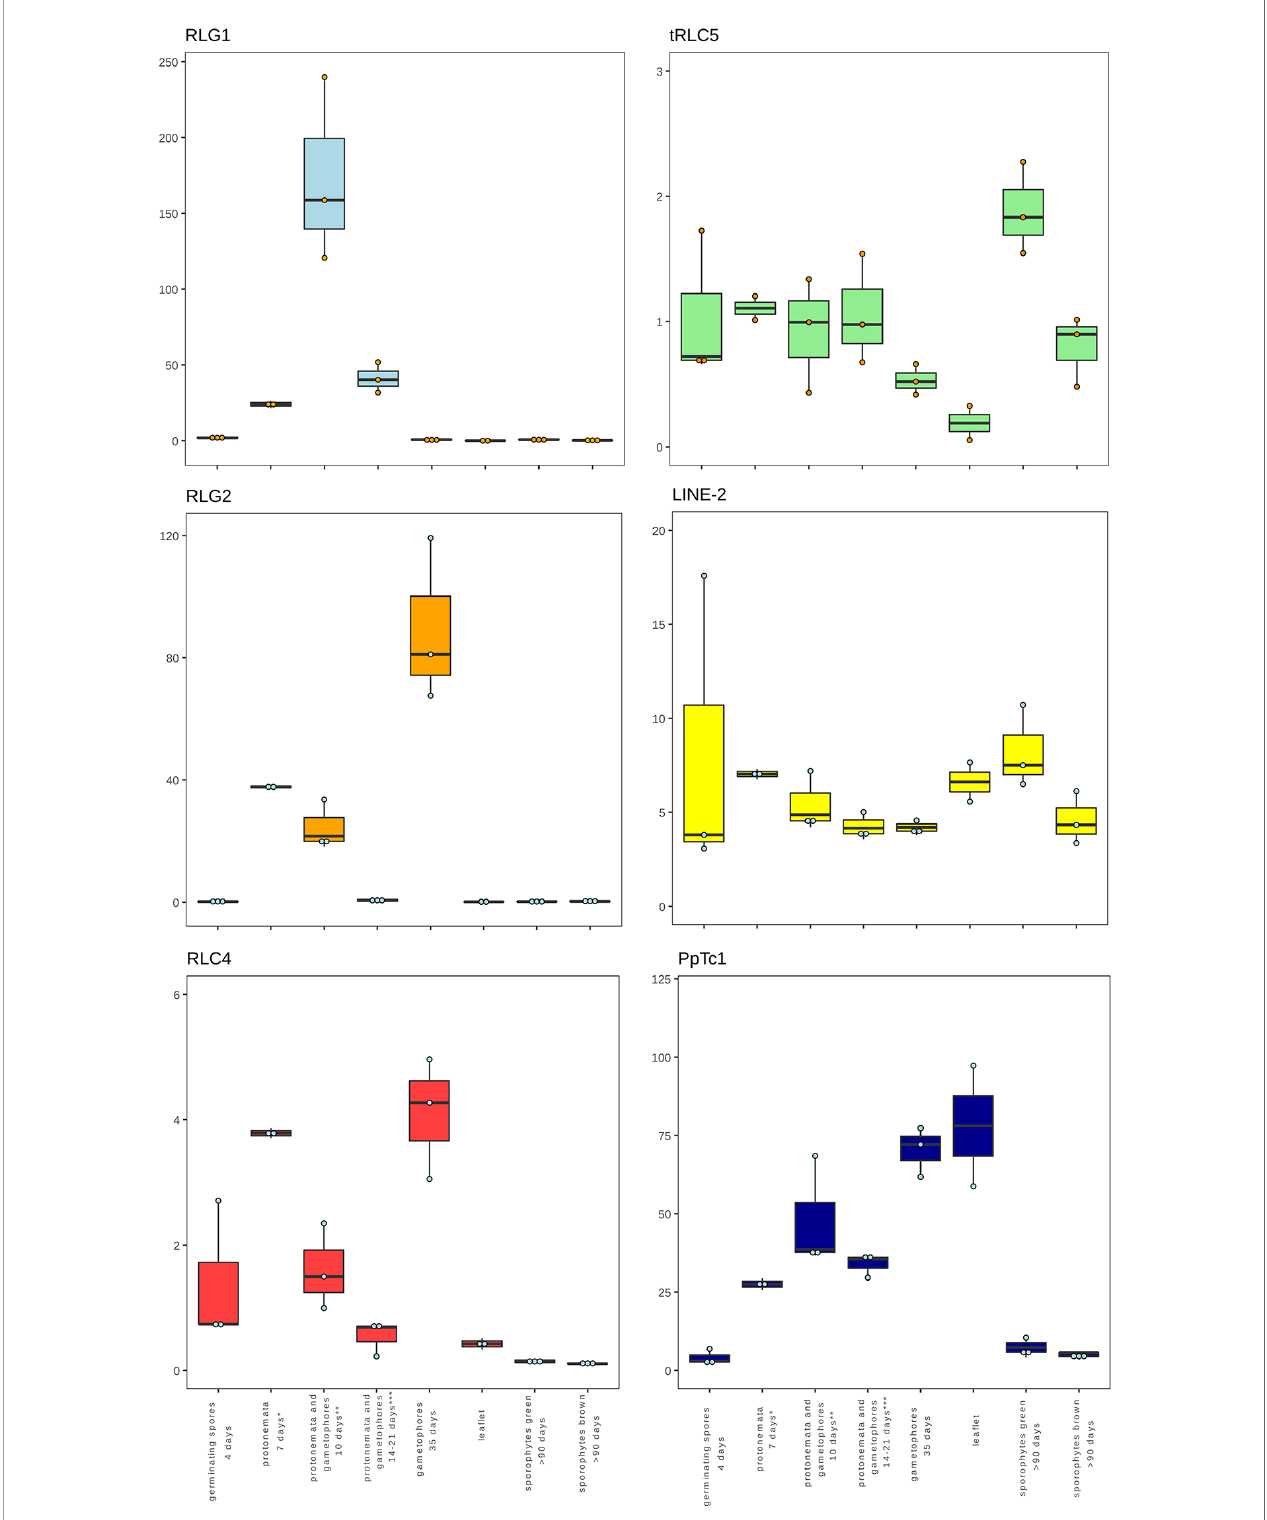
FIGURE 3 | Developmental expression of P. patens TEs. Normalized TE expression (see methods) in different developmental conditions selected from the P. patens Gene Atlas library (Perroud et al.,